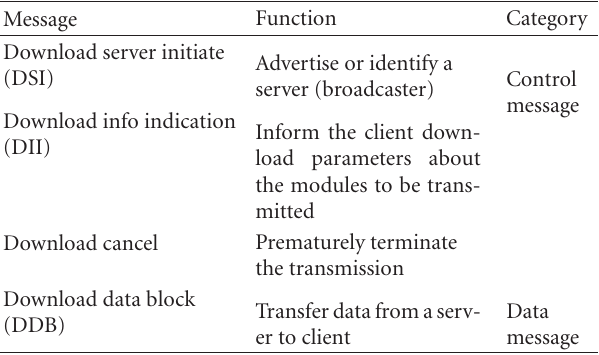
Table 1: DSM-CC download protocol